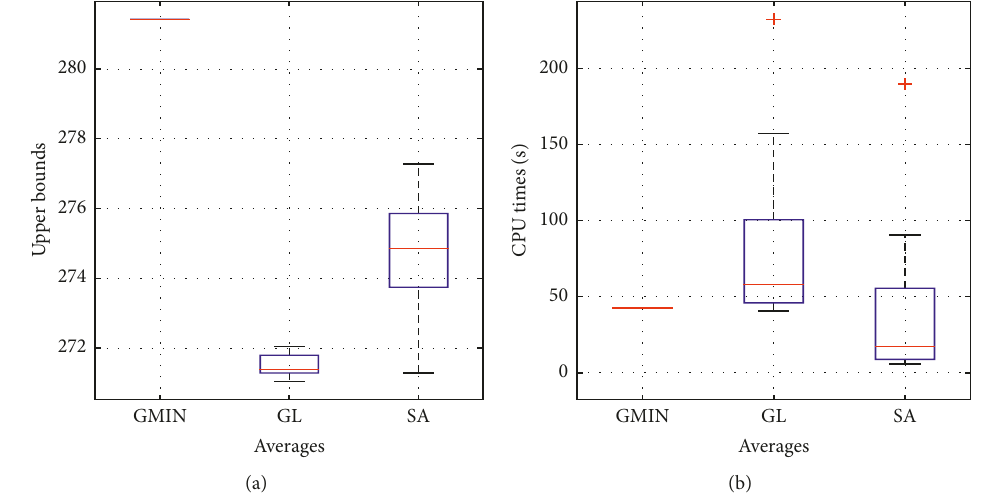
Figure 11: (a) Average upper bounds and (b) CPU times in seconds for the instance #10 in Table 9 while using a radial coverage value of